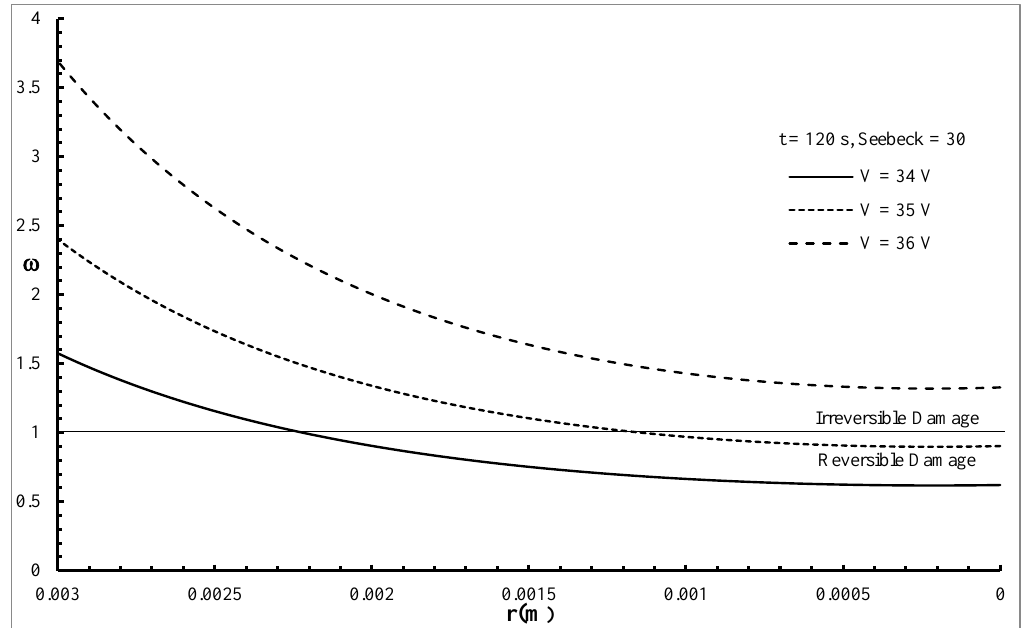
Figure 11 . The thermal damage distribution of myxoid liposarcoma tumor with various values of Figure 11. The thermal damage distribution of myxoid liposarcoma tumor with various values of R   . voltage when 75 voltage when R e = 75 Ω e